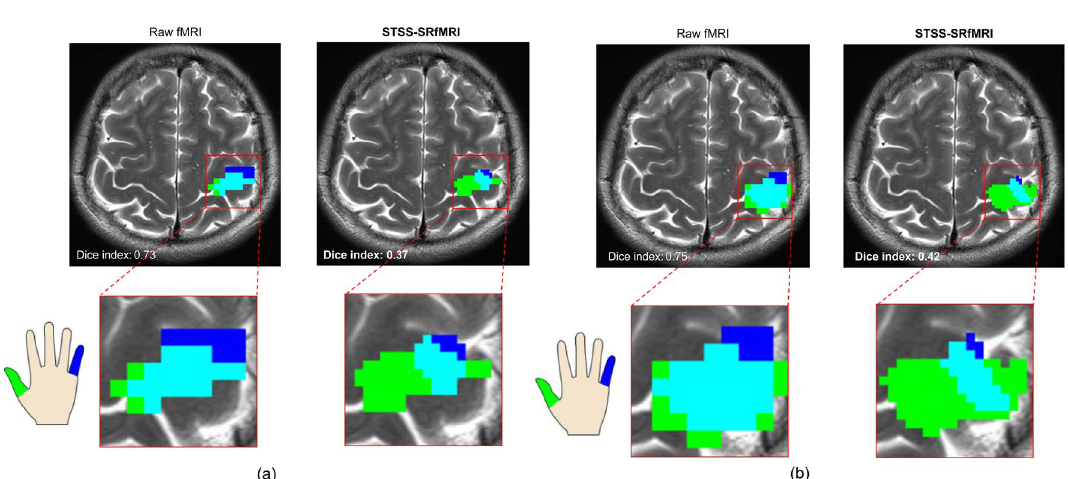
Figure 6. Two examples of the distribution of the activation-related regions. The colored voxels indicate regions that are highly correlated with only thumb-tapping (green), with only little finger-tapping (blue), and with both thumb and little finger tapping (light-blue). On visual inspection, the light-blue regions corresponding to the Static T2*WI-based Subject-Specific Super Resolution fMRI (STSS-SRfMRI) scheme are narrower than those of the raw fMRI maps, suggesting improved functional